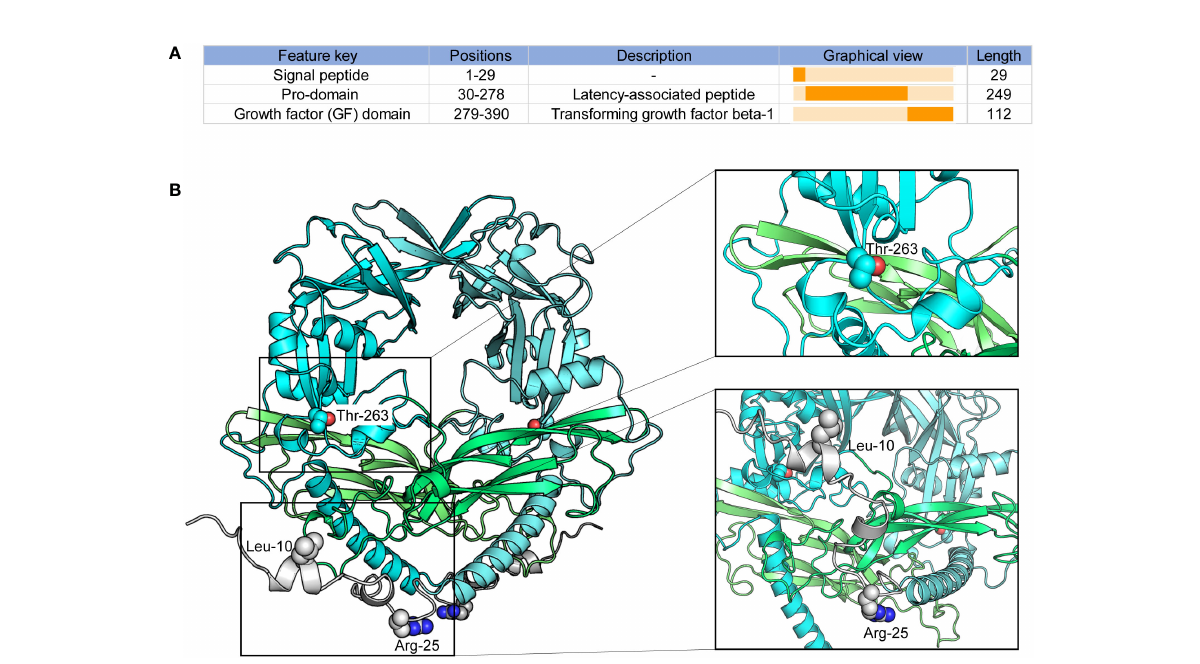
FIGURE 6 Peptide features and structure of TGF- b 1. (A) Peptide features of TGF- b 1; (B) Overall structure of TGF- b 1. Protein structures and residues are shown in cartoon and sphere representation,